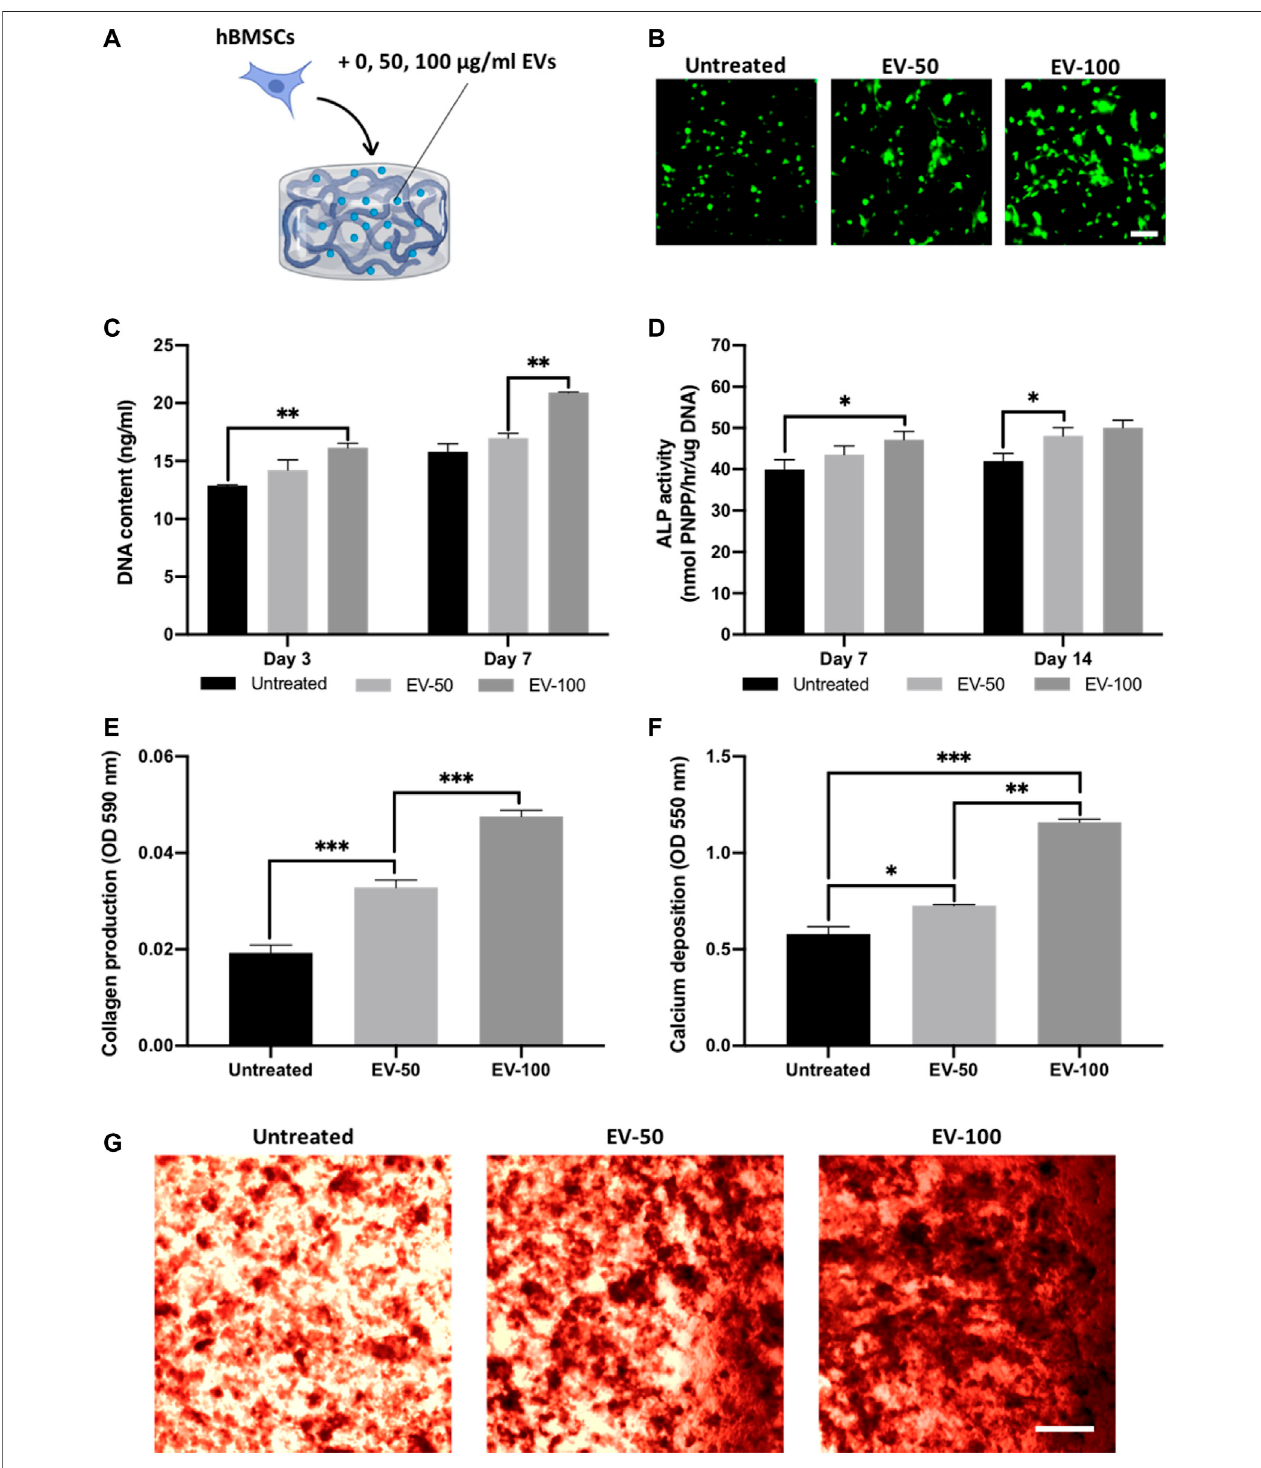
FIGURE 6 | The effect of EV-functionalised chitosan-collagen hydrogel on encapsulated hBMSCs osteogenic differentiation. (A) Schematic representation of EV- hydrogel groups (0 µg/ml = untreated, 50 µg/ml = EV-50, 100 µg/ml = EV-100). (B) Live/dead staining of encapsulated hBMSCs after 7 days of culture. Scale bar = 200 µm. (C) DNA content within EV-hydrogels after 7 days of culture. The in fl uence on EV-hydrogels on hBMSCs (D) ALP activity, (E) collagen production, and (F,G) calcium deposition during osteogenic culture. Black staining indicates mineral nodules. Scale bar = 200 µm. Data are expressed as mean ± SD ( n = 3). * p ≤ 0.05, ** p ≤ 0.01, and *** p ≤ 0.001.